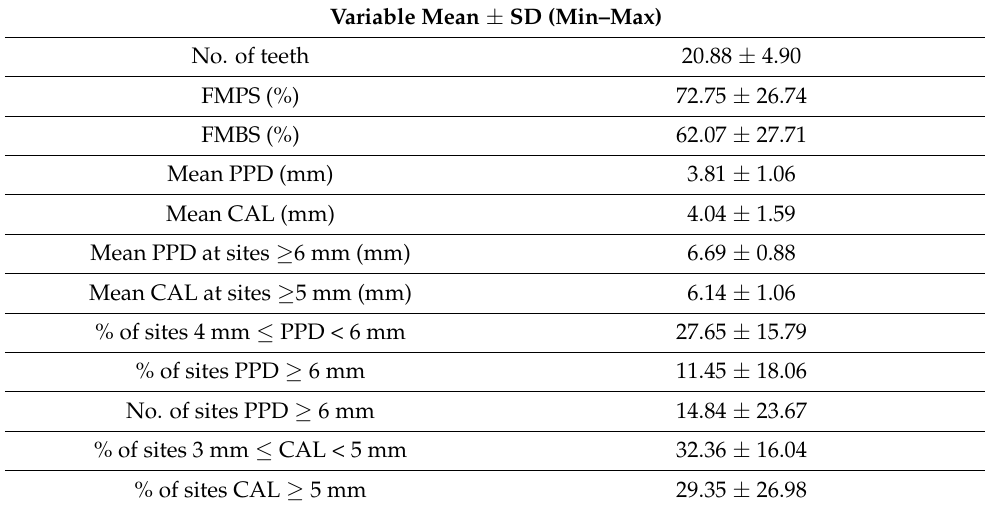
Table 1. Clinical periodontal parameters of subjects.